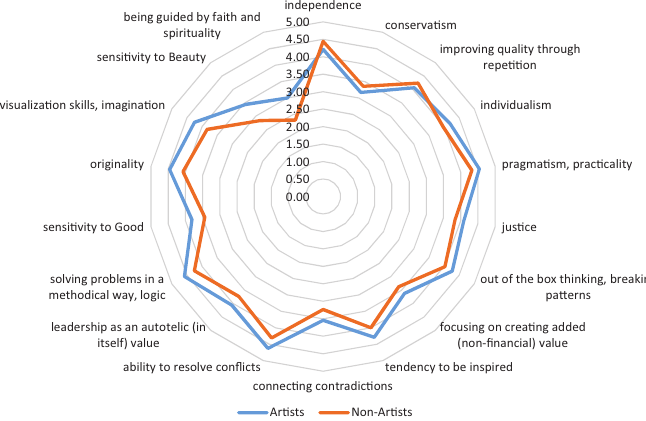
Figure 7. Perception of the most differently assessed features of an entrepreneur’s identity by artistic versus non-artistic individuals (source: created by